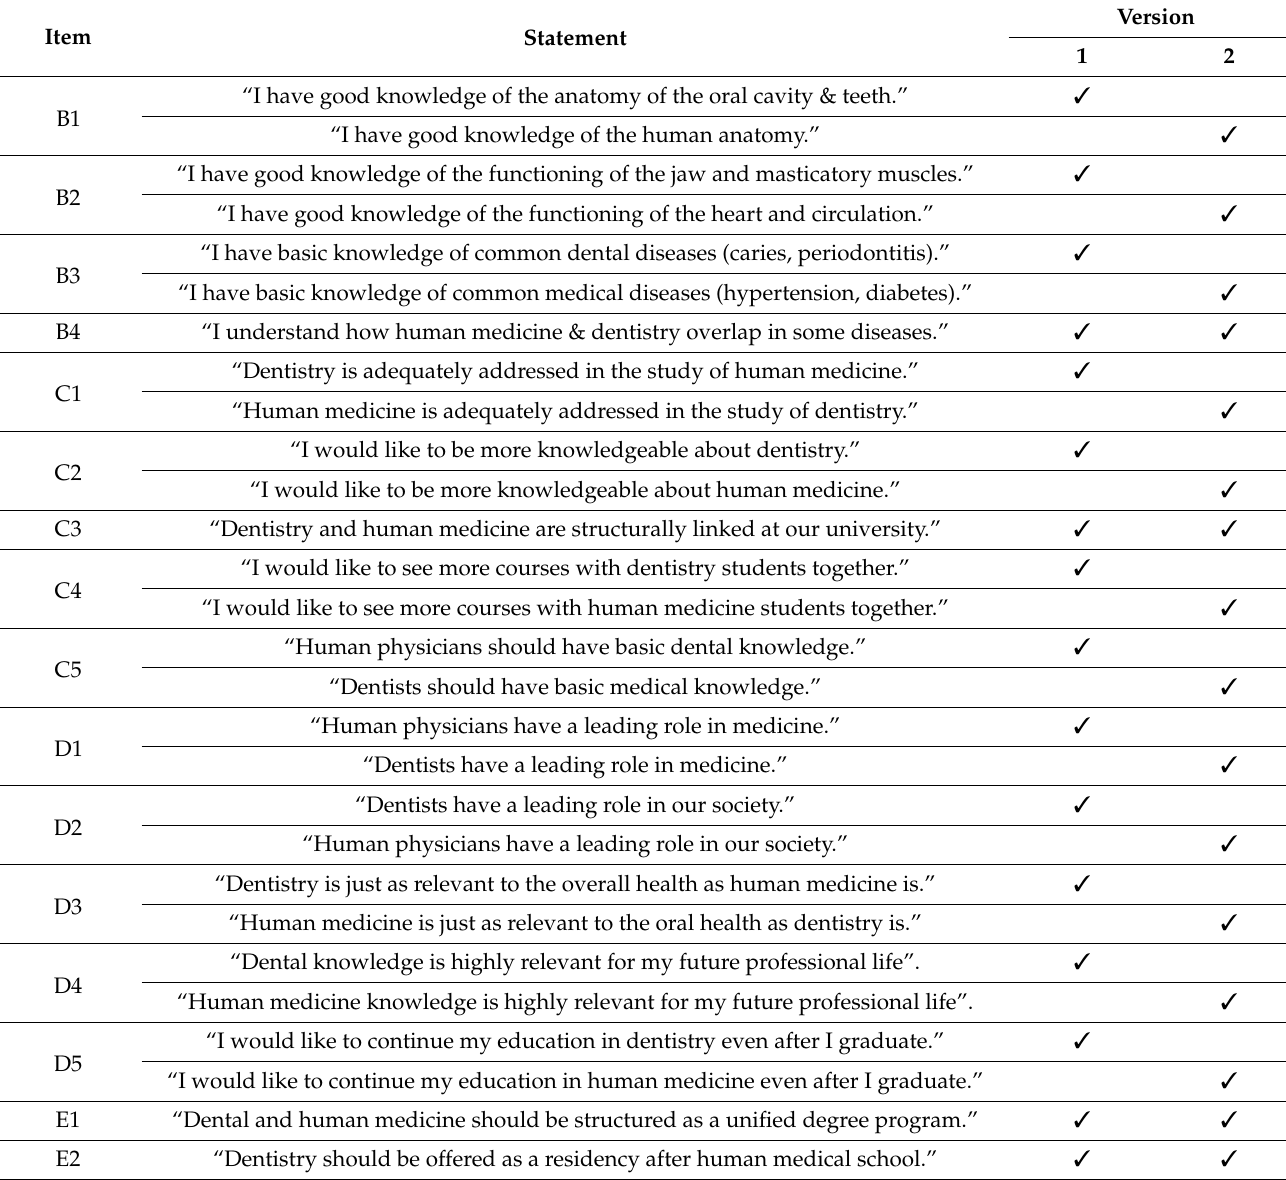
Table 1. Items of both questionnaires for medical and dental